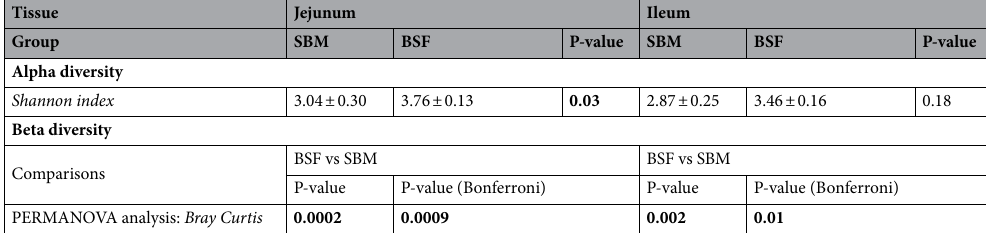
Table 1. Microbiota composition and diversity in jejunum and ileum digesta of pigs fed a diet with either soybean meal (SBM) or black soldier fly (BSF) as single protein